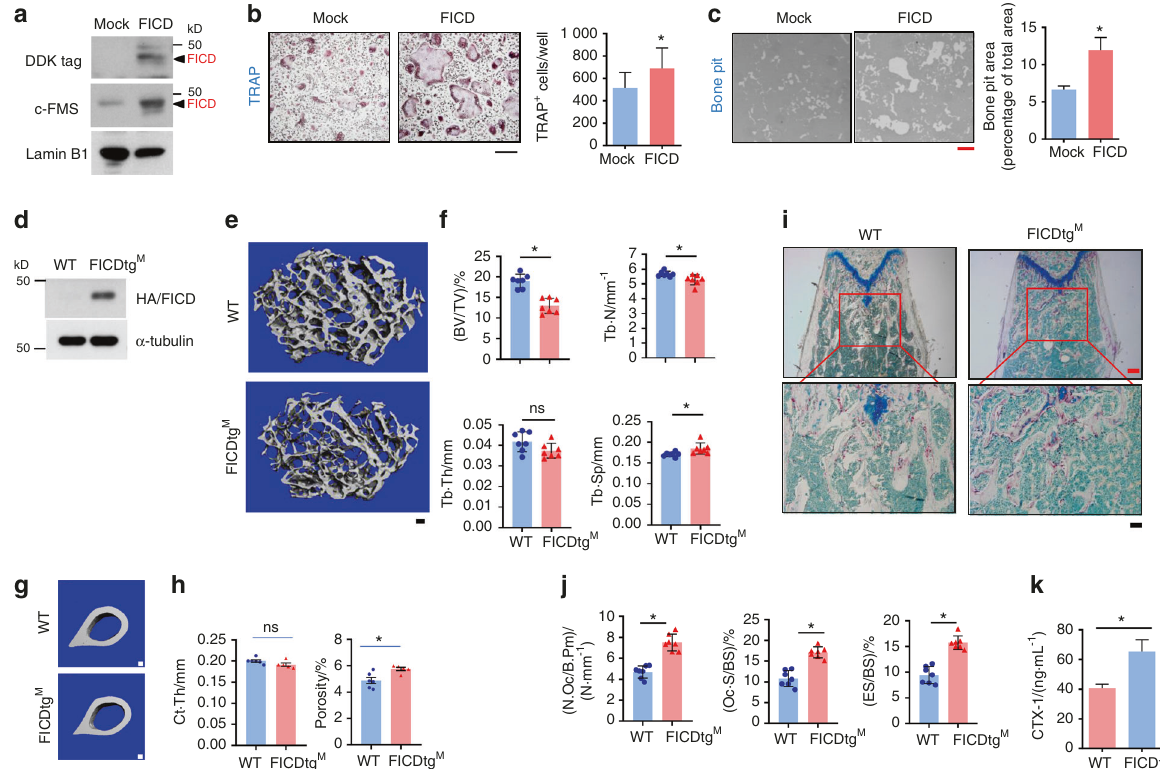
Fig. 4 FICDtg M mice exhibit an osteoporotic bone phenotype with increased osteoclast numbers. a , c BMDMs were transduced with retroviral particles encoding either control or FICD. a The protein expression of DDK-tagged FICD was determined by immunoblot analysis. b Osteoclastogenesis assay. The left panel shows representative images of TRAP-stained cells ( n = 4). c Bone resorption activity analysis. The left panel shows representative images, and the right panel shows the percentage of the resorbed pit area per total area ( n = 3). d BMDMs from wild type (WT) and FICDtg M mice. Immunoblot analysis of the expression of HA-tagged FICD protein. e – h Micro-CT analysis of femurs from 12-week-old male wild-type (WT) and FICDtg M mice ( n = 7). Scale bar: 100 µm. e Representative images of distal femurs. f Bone parameters in distal femurs. Bone volume/tissue volume ratio (BV/TV), trabecular thickness (Tb.Th), trabecular number (Tb.N), and trabecular space (Tb.Sp) were determined by micro-CT analysis. g Representative images of cortical bone. h Cortical bone parameters. Cortical bone thickness (Ct.Th) and Cortical porosity. i , j Histomorphometric analysis of the distal femurs of 12-week-old male WT and FICDtg M mice ( n = 6). i Representative image showing TRAP-positive, multinucleated osteoclasts (red). j The number of osteoclasts per bone surface (N.Oc/BS), osteoclast surface area per bone surface (Oc.S/BS), and eroded surface per bone surface (ES/BS). k CTX-1 (WT = 5, FICDtg M = 8) in the sera of WT and FICDtg M mice. All data are shown as the mean ± SEM. ns, not signi fi cant. * P < 0.05 by two-tailed, unpaired t -test ( b , c , f , h , i